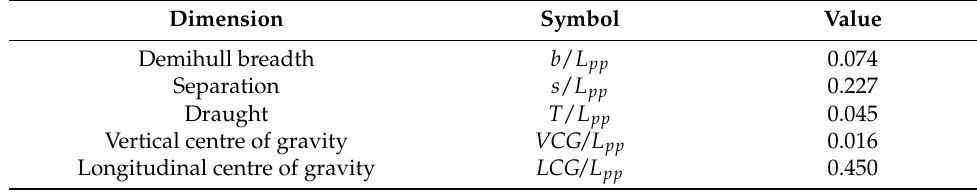
Table 3. Main dimensions of the Stavanger Demonstrator catamaran.